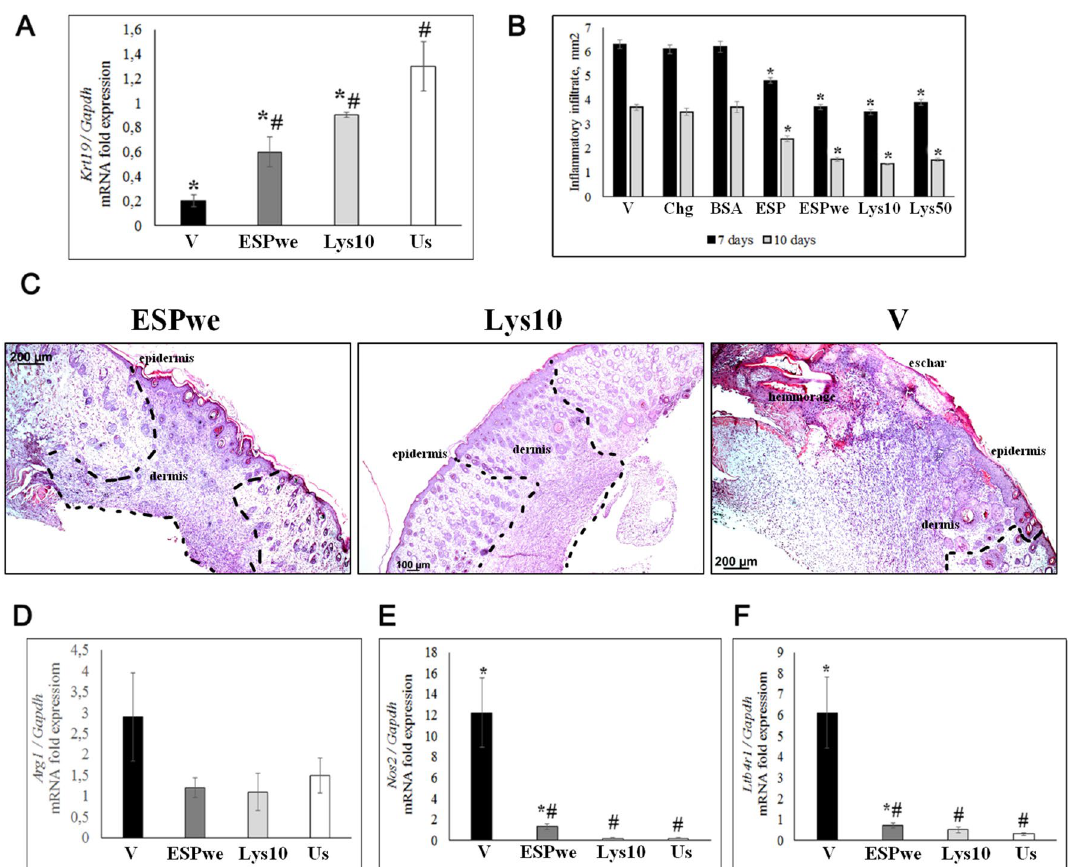
Figure 2. General wound healing evaluation. ( A ) Cytokeratin 19 ( Krt19 ) gene expression normalized to Gapdh gene expression. V vehicle, ESPwe excretory-secretory product without endotoxin 10 µg, Lys 10 Lysate 10